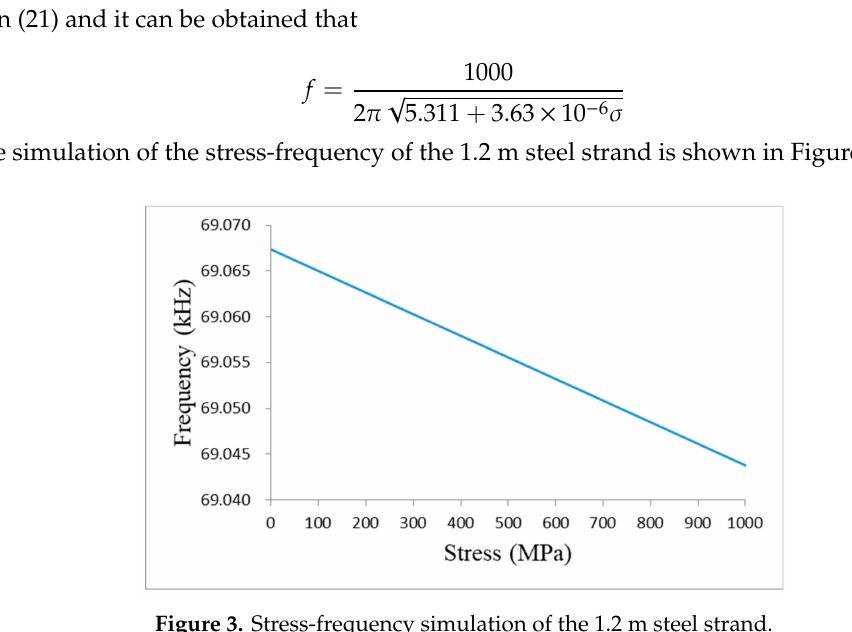
Figure 3. Stress-frequency simulation of the 1.2 m steel strand.